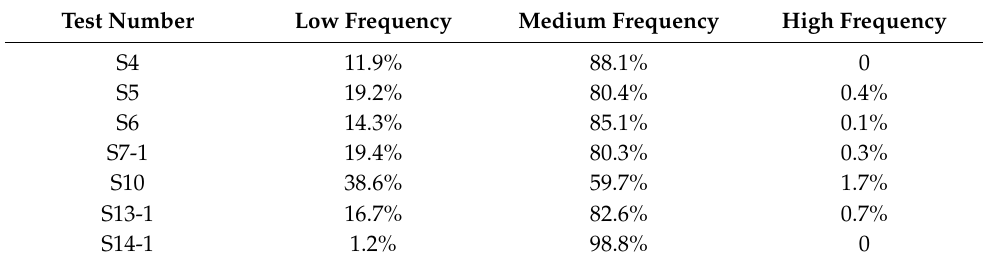
Table 3. Percentage of peak frequency of the